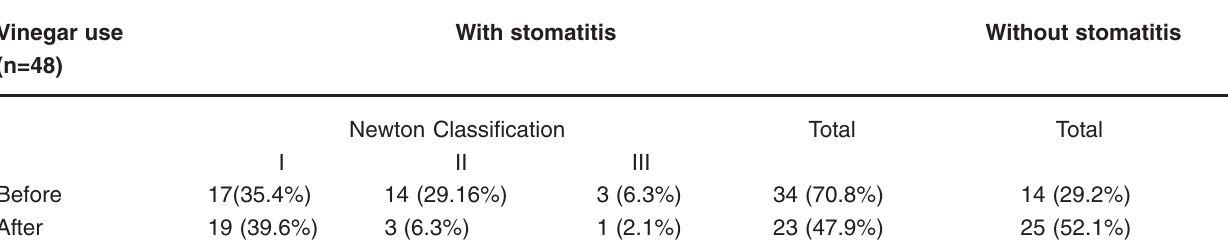
TABLE 2- Percentage of patients with or without denture-induced stomatitis, before and after the use of vinegar